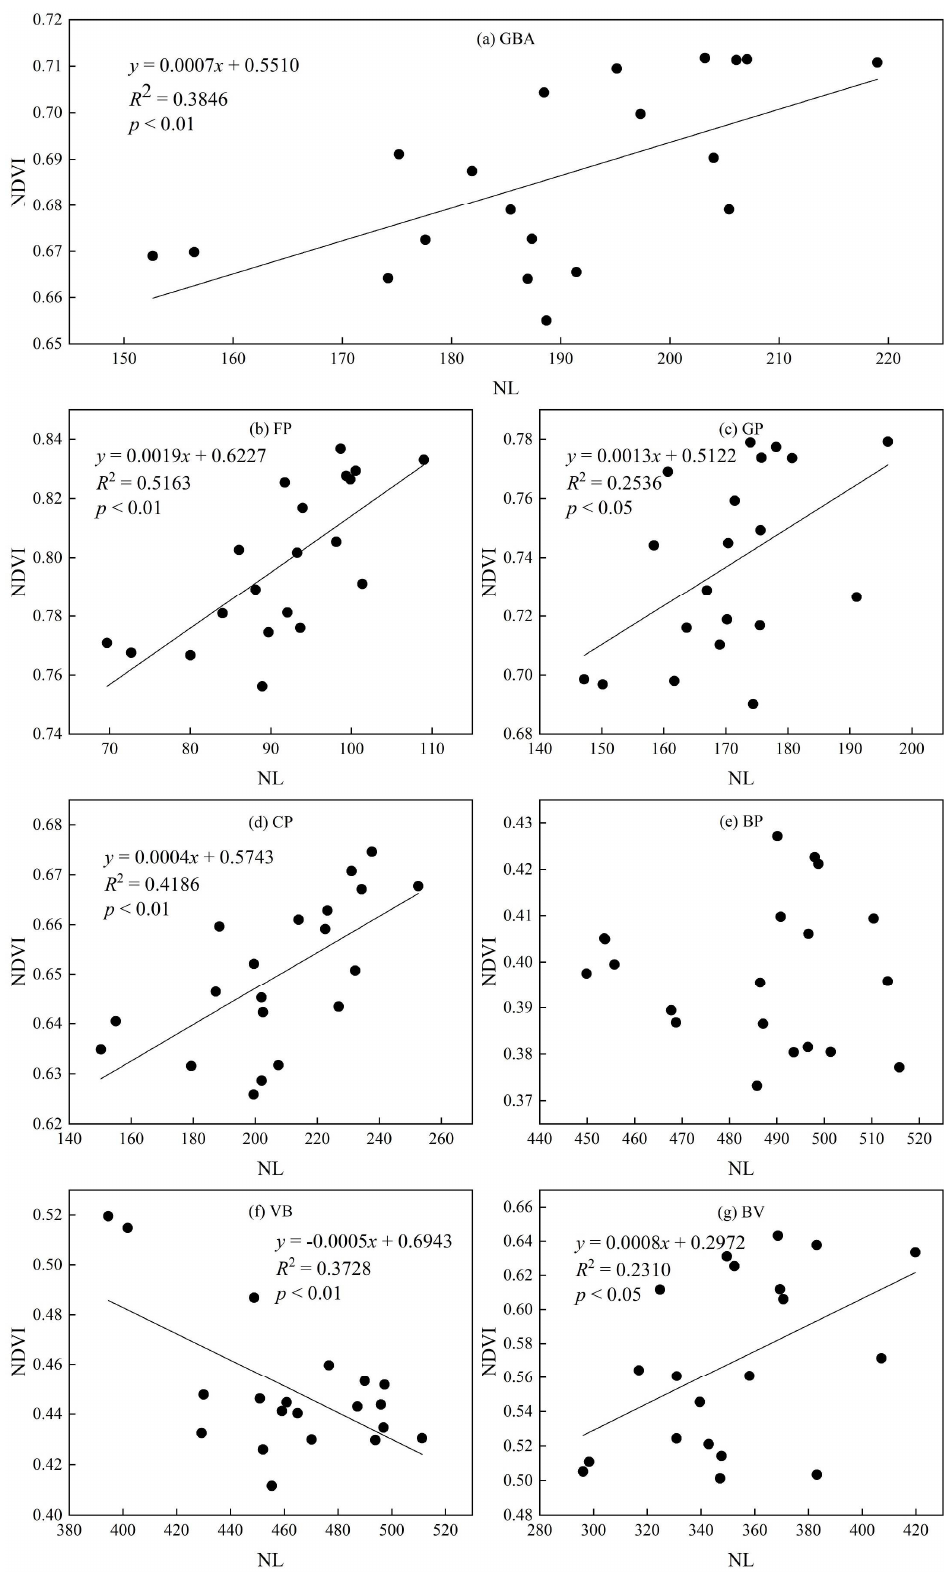
Figure 5. Correlations of NDVI and NL for the period 2001–2020. ( a ) Linear regression between NDVI and NL for the whole GBA; ( b – g ) linear regression between NDVI and NL across different LUCC types. NL—night light; FP—forest persistence; GP—grassland persistence; CP—cropland persistence; BP—built-up persistence; VB—vegetation to built-up; BV—built-up to